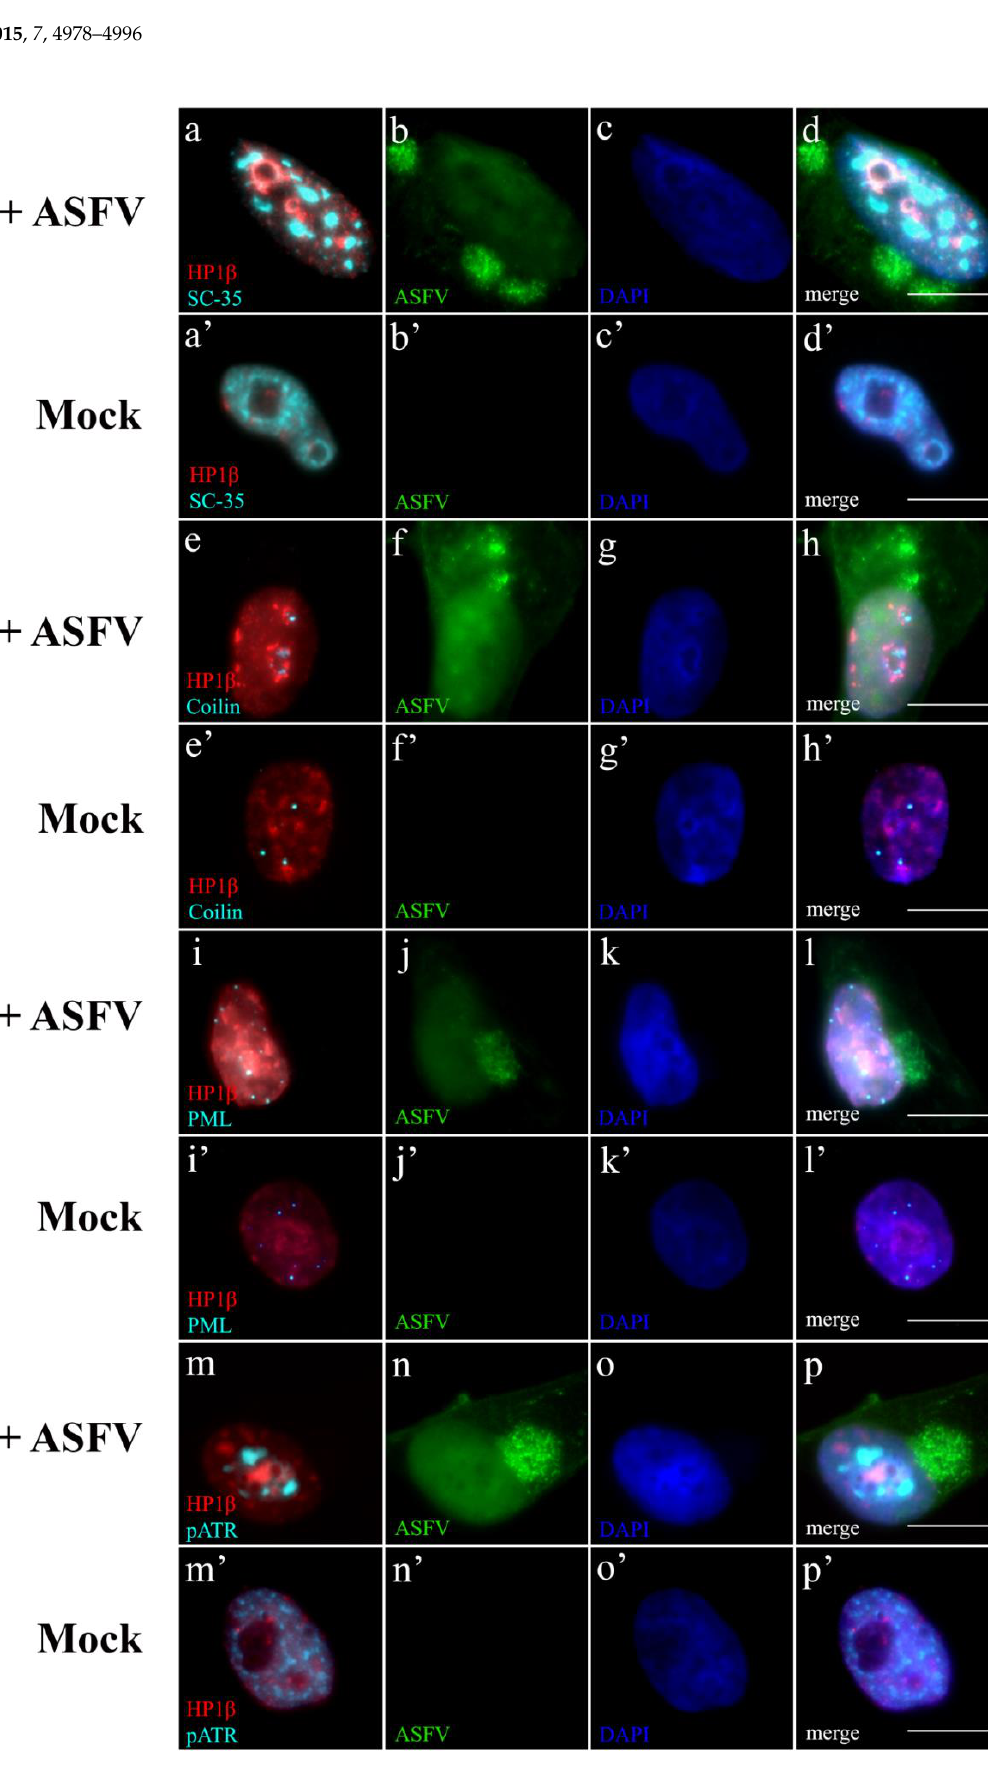
Figure 5. Cont Figure 5. Cont.